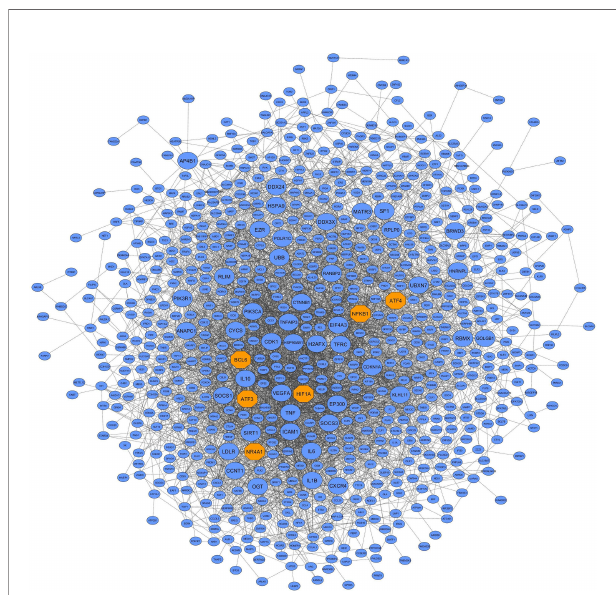
FIGURE 5 | PPI network based on the co-expressed hub genes of the blue module. This module had the most biological associations with the immunopathogenesis of COVID-19. Large circles and orange octagons represent hub-high traf fi c genes and TFs,